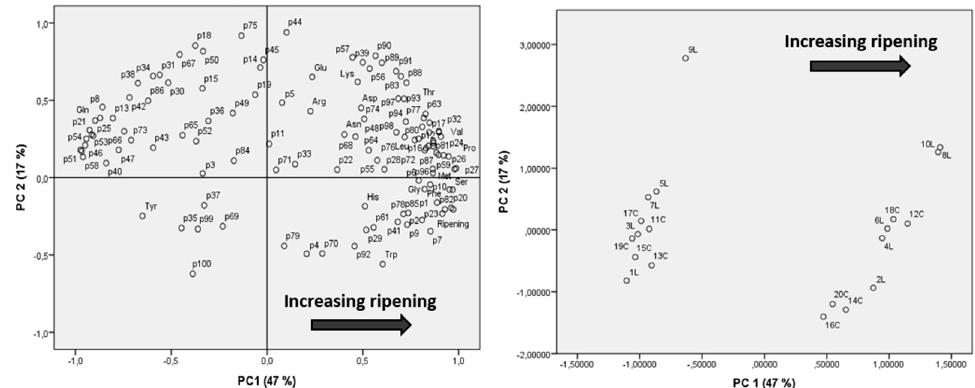
Figure 5. Loading plot (left) and scores plot (right) of the principal component (PC) analysis performed over the samples analyzed by using peptide semiquantitative data and amino acid concentrations as variables. The 15-month-ripened samples are circled in gray and the 30-month-ripened samples in black. Samples are labeled by their salt content (L = low salt, C = conventional), whereas peptides are indicated according to their number (in order of molecular weight). Variance